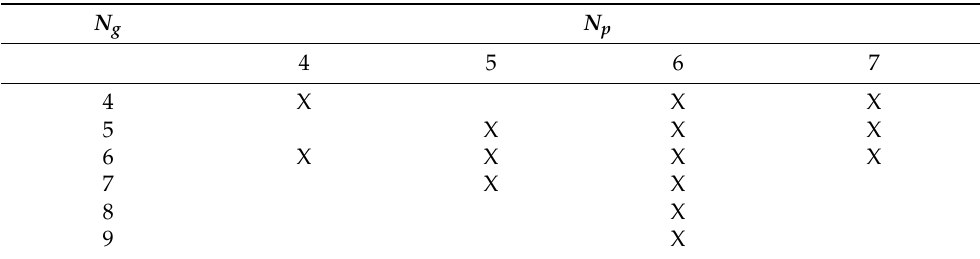
Table 5. Exponents of optimal models. N g N